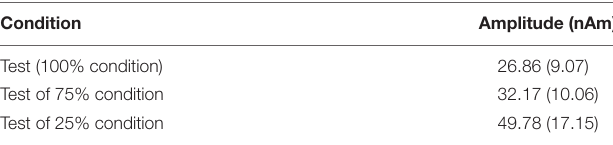
TABLE 1 | Mean amplitude of N100m for the test stimulus under the three probability conditions. Condition